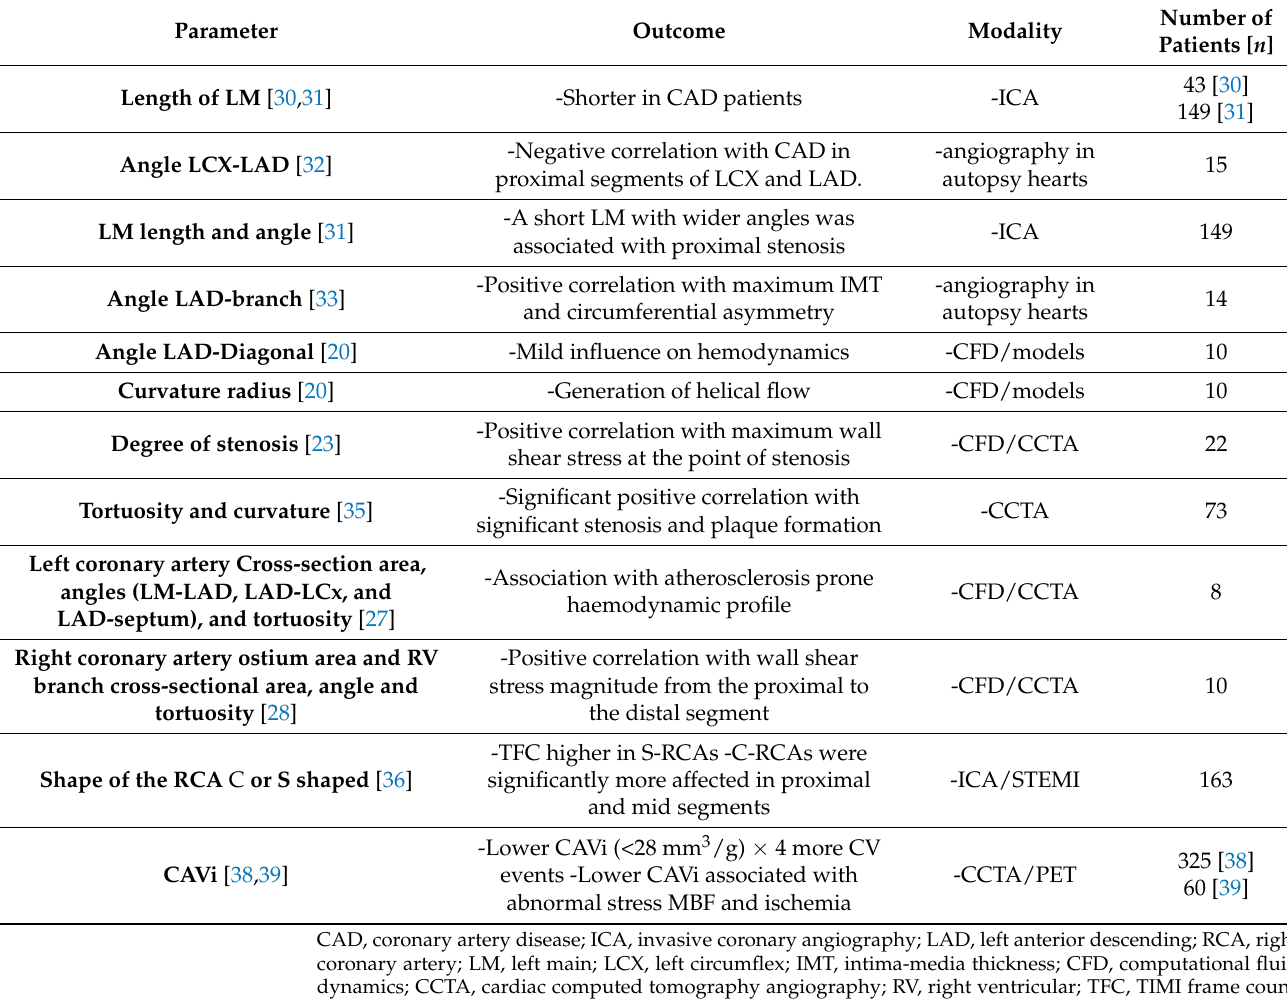
Table 1. Relationship between main geometric features proposed in the literature and